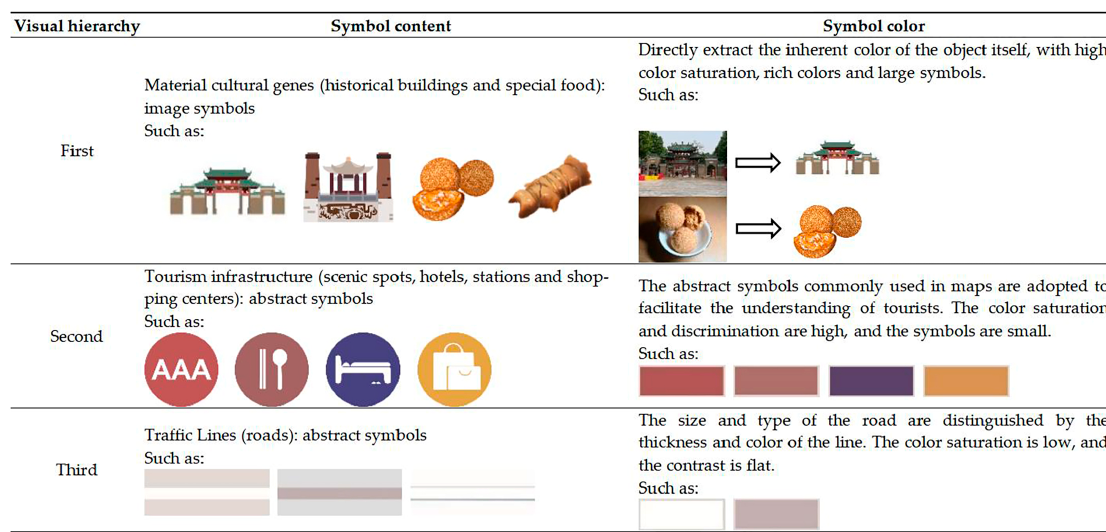
Figure 4. Color extraction of tourist attractions (Ancestral Temple).